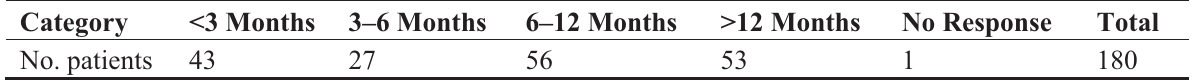
Table 2. Length of attendance of interviewed patients at MDWMC.